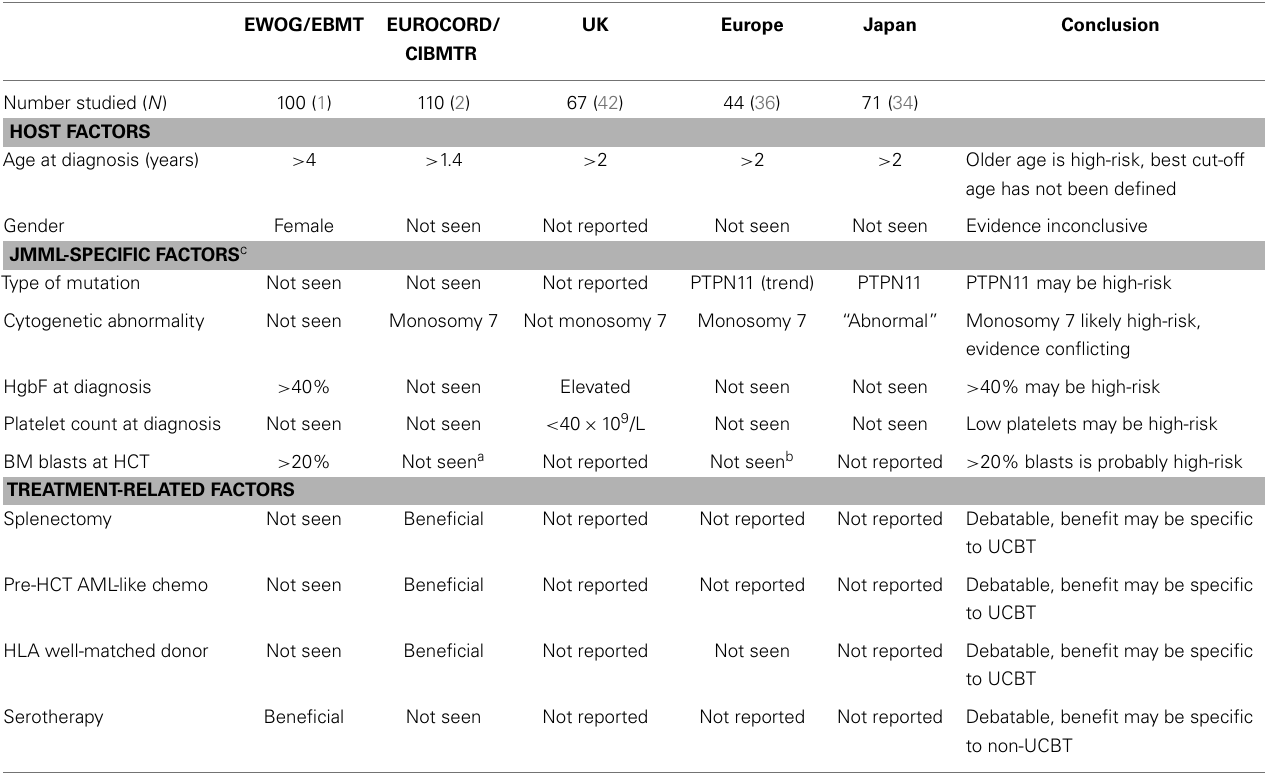
Table 2 | Juvenile myelomonocytic leukemia high-risk